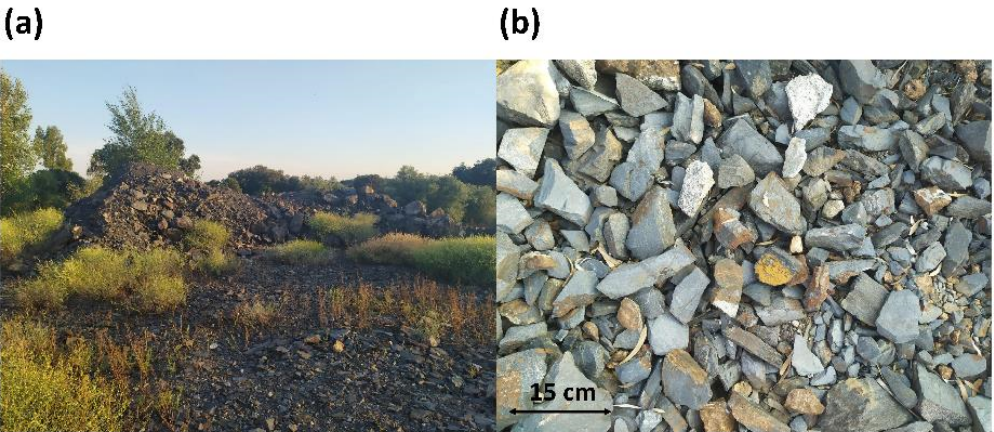
Figure 1. Image of the “EL COBRE” seam waste dump. ( a ) General image of the waste dump and ( b ) ( b ) detailed image of the di ff erent particles that make it detailed image of the different particles that make it up.